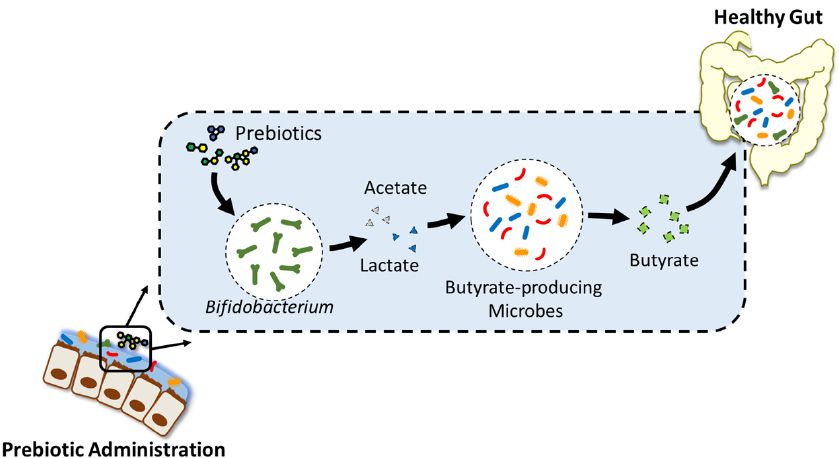
Figure 2. Cross-feeding effect between Bifidobacterium and butyrate-producing bacteria. Bifidobacterium utilises supplemented prebiotics, which stimulates their growth. Acetate produced by Bifidobacterium becomes a carbon source for butyrate-producing microbes, stimulating their growth and butyrate-producing activities and, in turn, modulating the microbiome function and improving gut health.